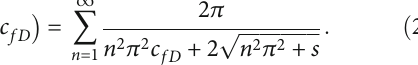
ffiffiffiffiffiffiffiffiffiffiffiffiffiffiffiffi